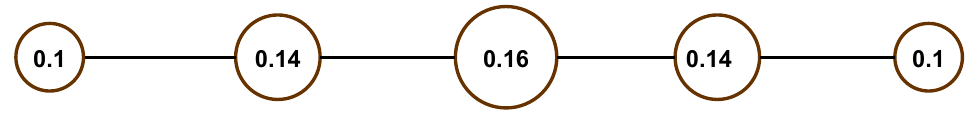
Figure 3. Instance of a path graph ( P 5 ) with centrality scores based on